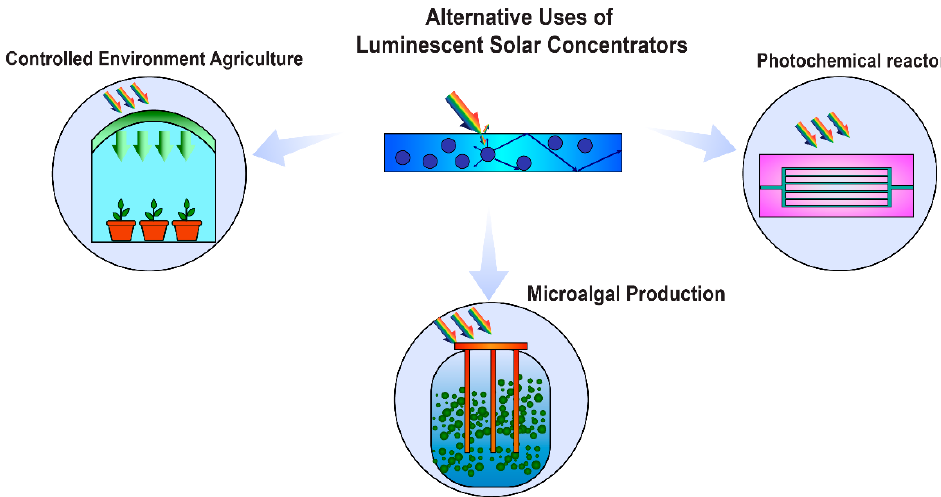
Figure 2. LSCs can be used in various applications, such as agriculture, microalgal production, and photochemical synthesis.